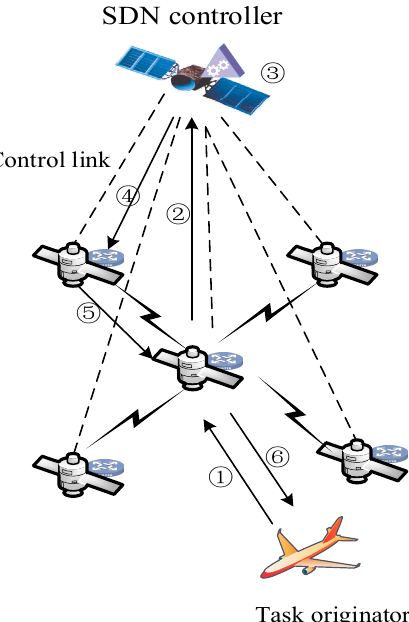
Figure 1. The satellite network scenario.